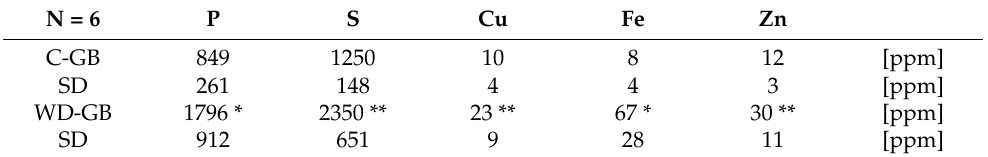
Table 3. Mean element concentrations in ppm ± SD in control gallbladder (C-GB) and WD-GB (N = 6). Significant differences are indicated by * for p < 0.05, or ** for p < 0.01.